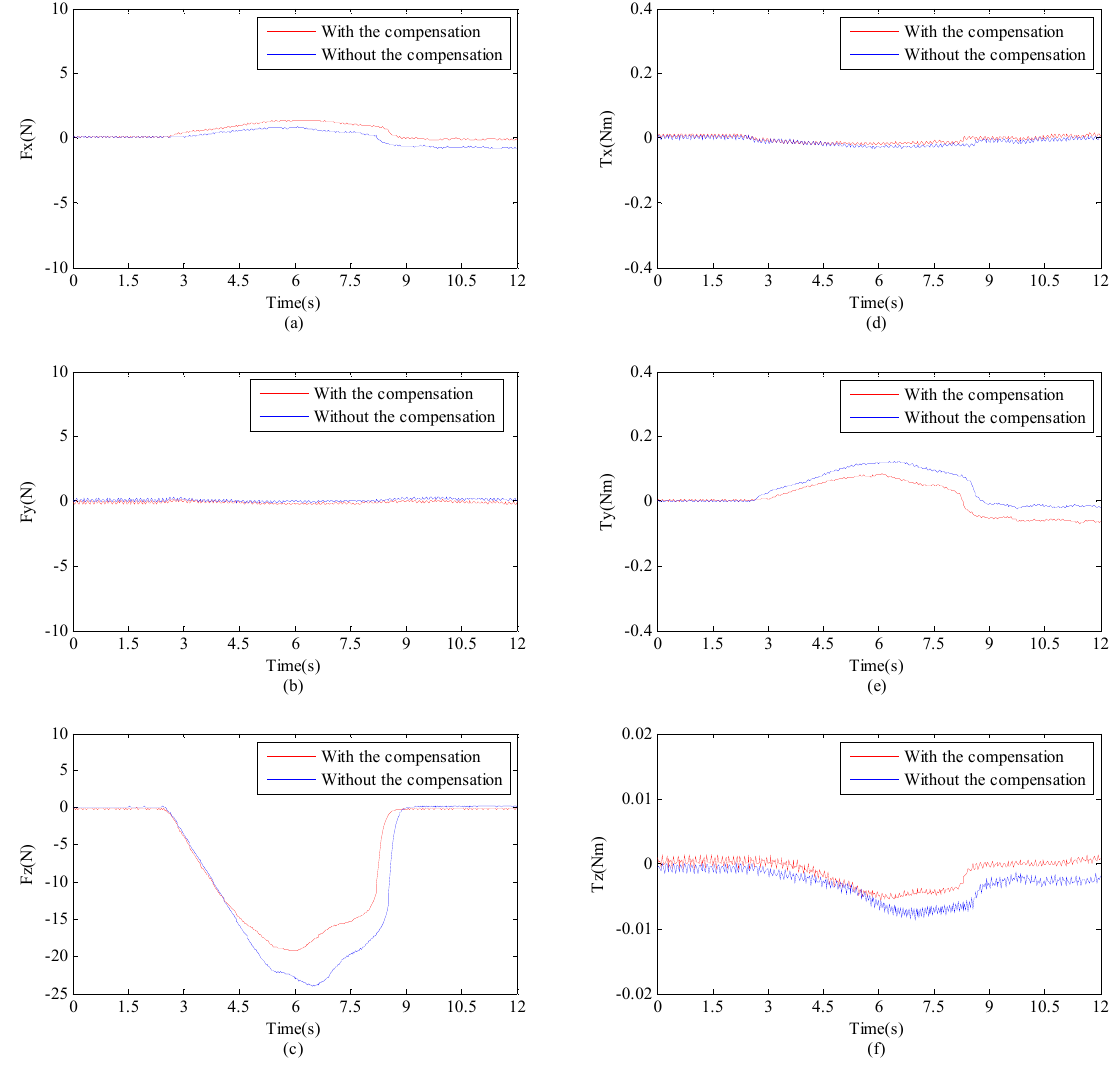
Figure 10. The forces and torques during the drilling operation of R1. ( a ) Fx is the force along x -axis; ( b ) Fy is the force along y -axis; ( c ) Fz is the force along z -axis; ( d ) Tx is the force around x -axis; ( e ) Fy is the force around y -axis; ( f ) Fz is the force around z -axis.